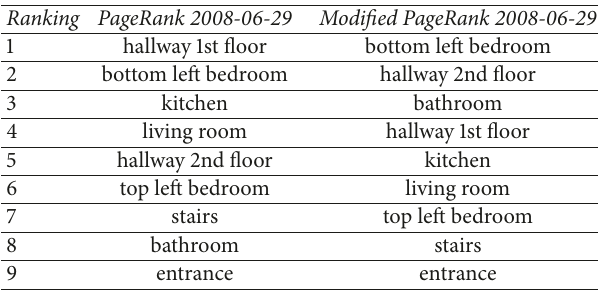
Table 6: Results of the third